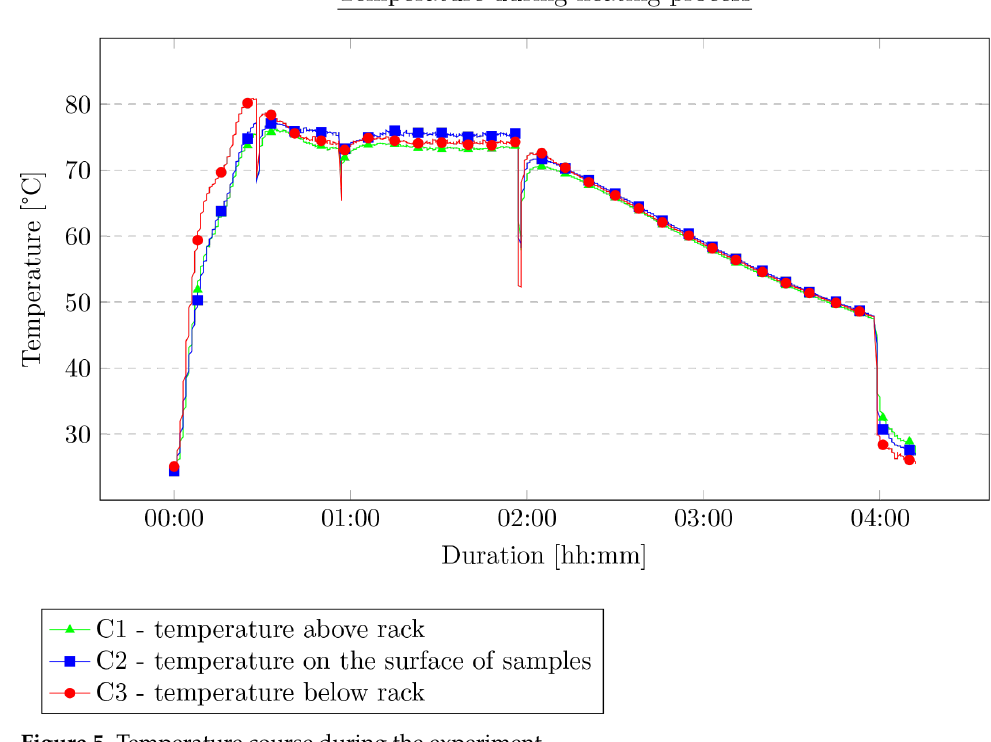
Figure 5. Temperature course during the experiment.